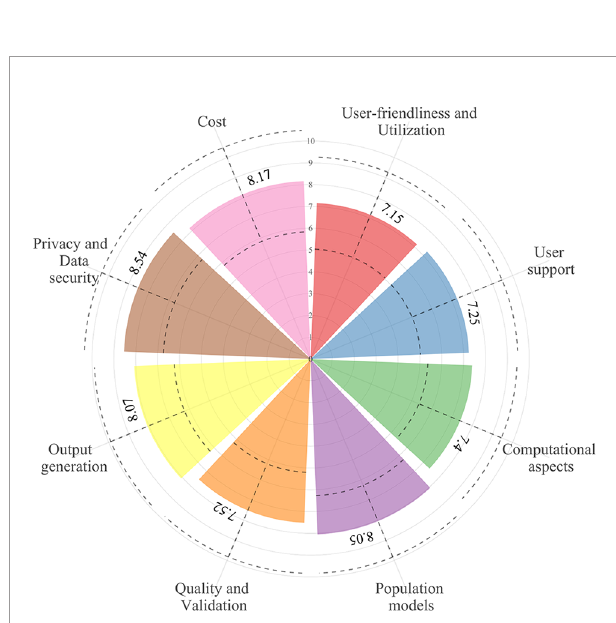
FIGURE 3 | The overall mean (±1 pooled standard deviation; dashed lines) of importance levels of the considered criteria in the eight categories.